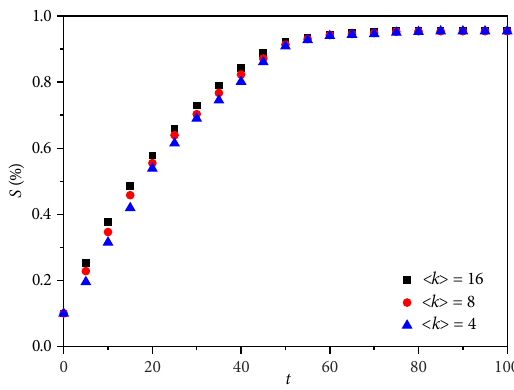
Figure 8. Cascade effect is influenced by the network size Figure 9. Cascade effect is influenced by average